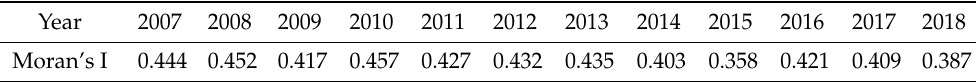
Table 3. Global Moran’s I of coupling coordination degree from